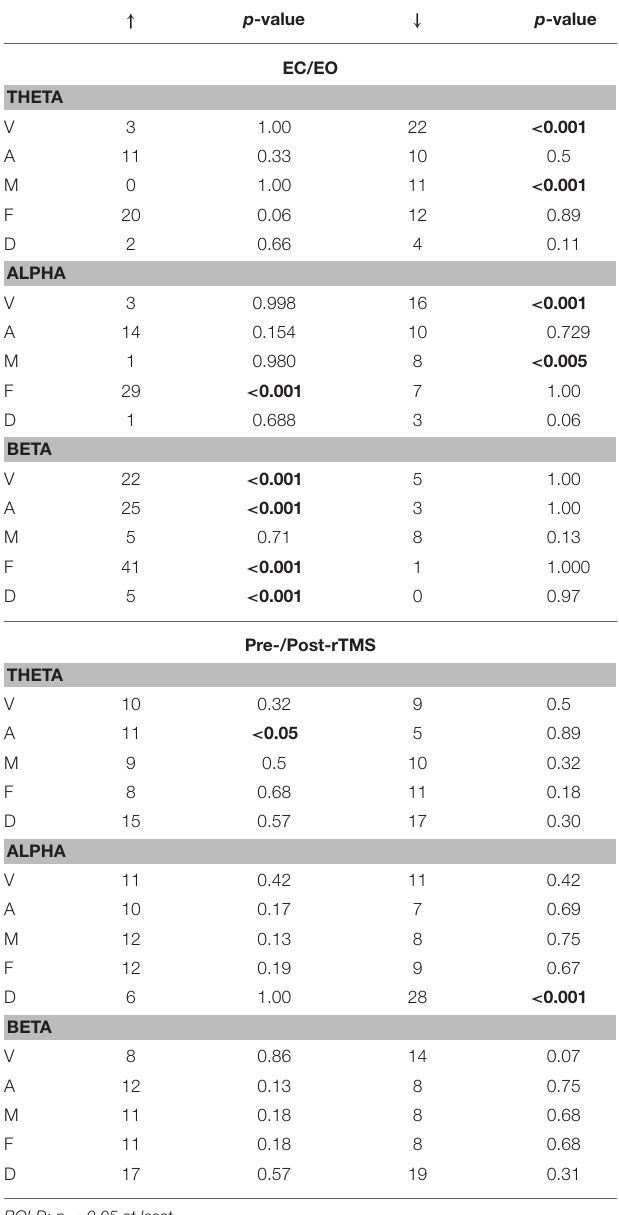
TABLE 1 | Summary of spectral power differences of five RSN classes between data from two conditions in one dataset: (A) EC/EO and (B)